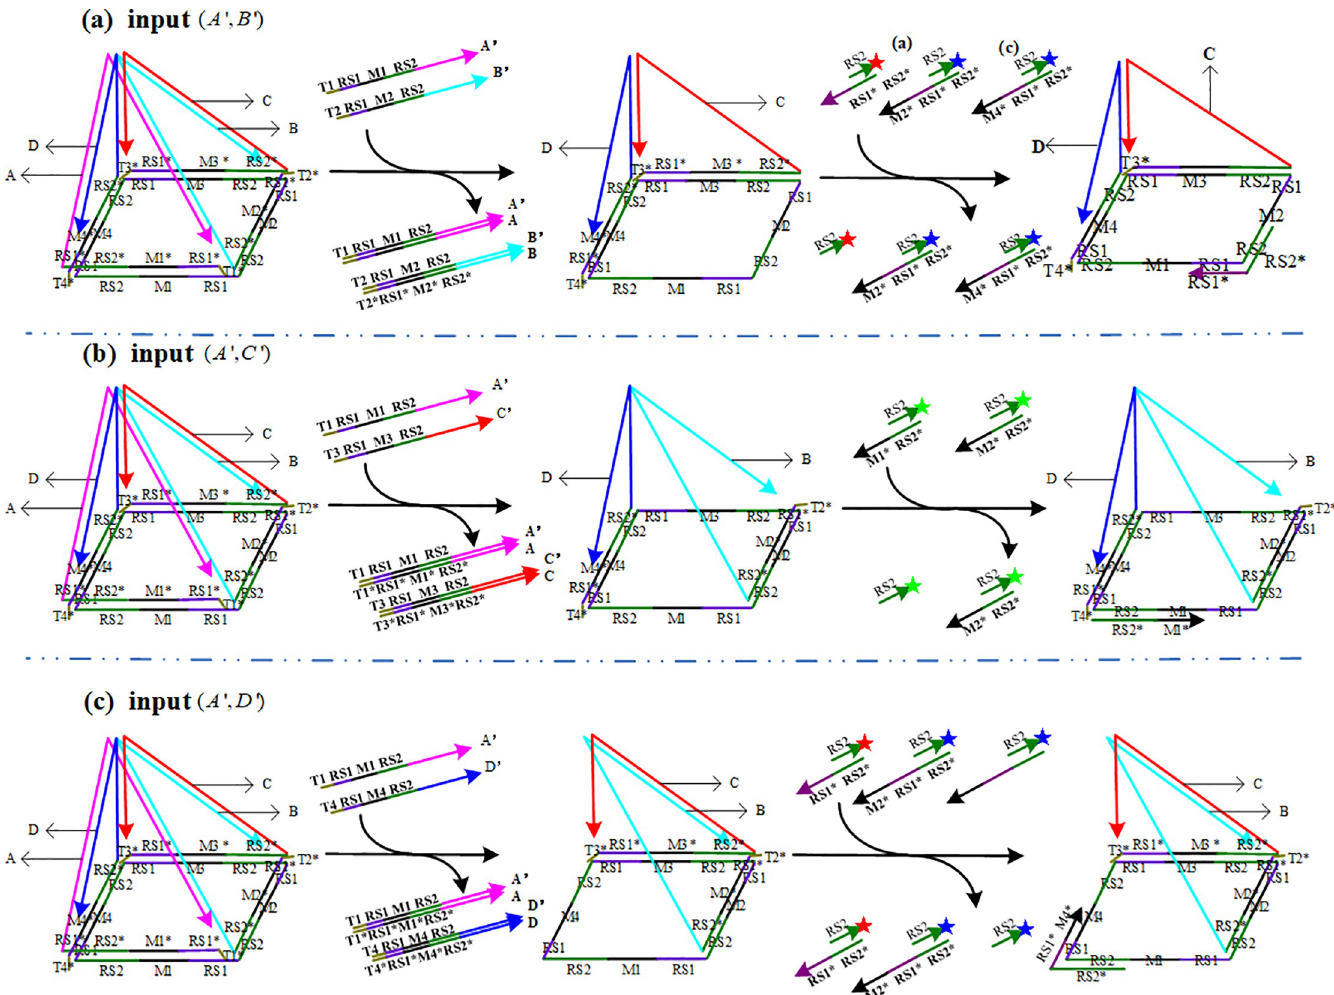
Fig 5. There different displacement processes. (a) The displacement process when adding A ’ and B ’. (b) The displacement process when adding A ’ and C ’. (c) The displacement process when adding A ’ and D ’.